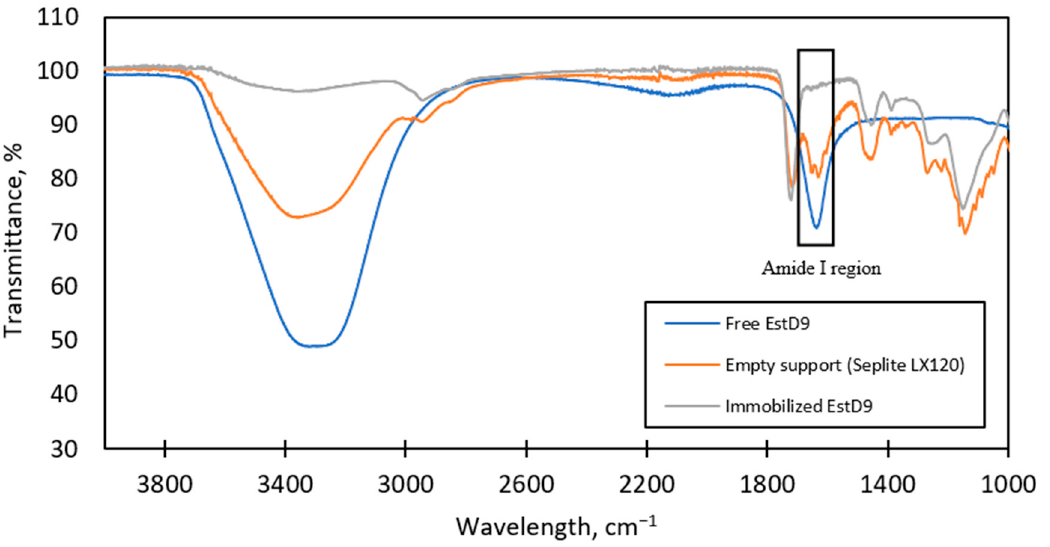
Figure 5. FT-IR spectral profile of free EstD9, empty Seplite LX120, and immobilized EstD9. Blue line represents free EstD9, while the empty Seplite LX120 and immobilized EstD9 are denoted in orange and grey lines, respectively.